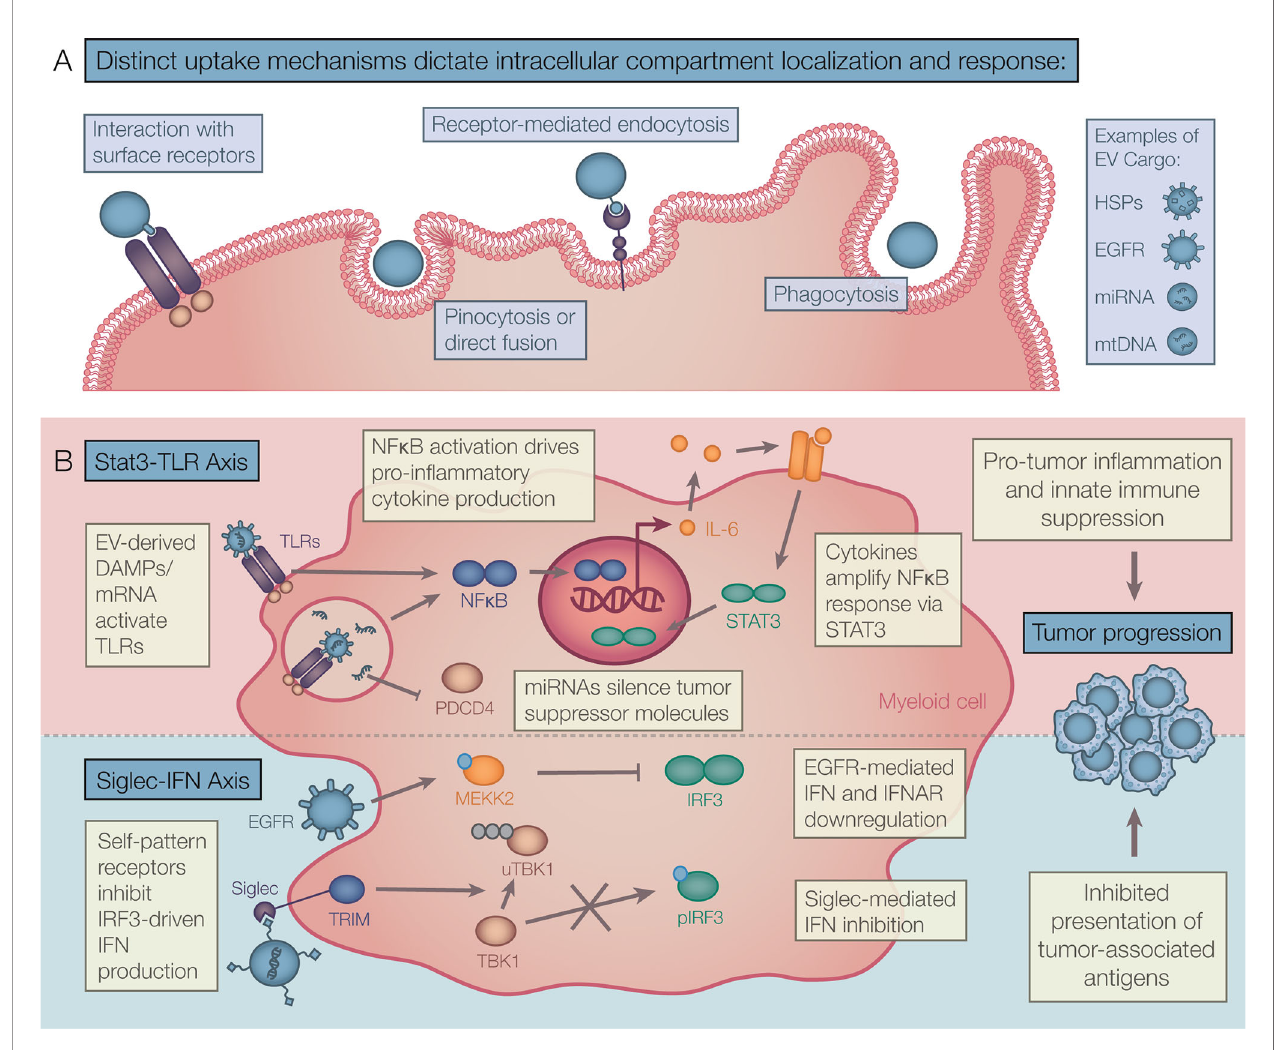
FIGURE 2 | Theoretical framework for tumor EV driven myeloid responses. (A) EV capture mechanisms include binding directly to cell surface receptors, direct fusion, and internalization by pinocytosis, receptor-mediated endocytosis, and phagocytosis. Distinct capture mechanisms deliver EV cargo to compartment-speci fi c receptors driving diverse EV responses in recipient myeloid cells. (B) A range of tumor EV cargos act together to drive tumor promoting in fl ammation. Chronic interaction with EV-DAMPs and other effectors activate NF- k B and STAT3 signalling resulting in accumulation of late-stage cytokines. Also, self-molecular patterns and other effectors found in EVs attenuate type I IFN production and/or response. These signals can modulate acute in fl ammation and presentation of tumor antigens. EV, Extracellular vesicle; DAMPs, Danger-associated molecular patterns; NF- k B, Nuclear factor Kappa B; STAT, Signal transducer and activator of transcription; IFN,